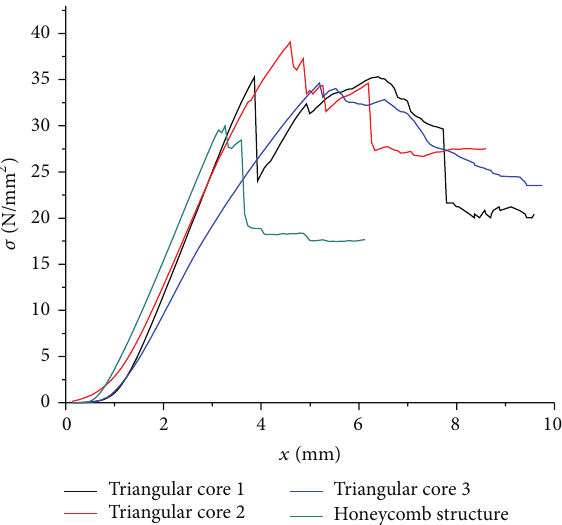
Figure 10: Bending behaviors of the triangular sandwich structure (specimen1).(a)Elasticdeformation.(b)Skinbucklinganddebond- ing. (c) Core shear.